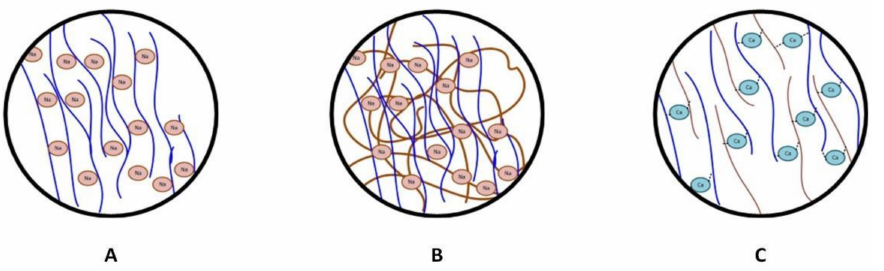
Figure 6. Simplified illustration of SA/KC crosslinking mechanism using Ca: ( A ) sodium alginate structure, ( B ) sodium alginate/ κ -carrageenan mixture, ( C ) Ca crosslinked alginate/ κ -carrageenan